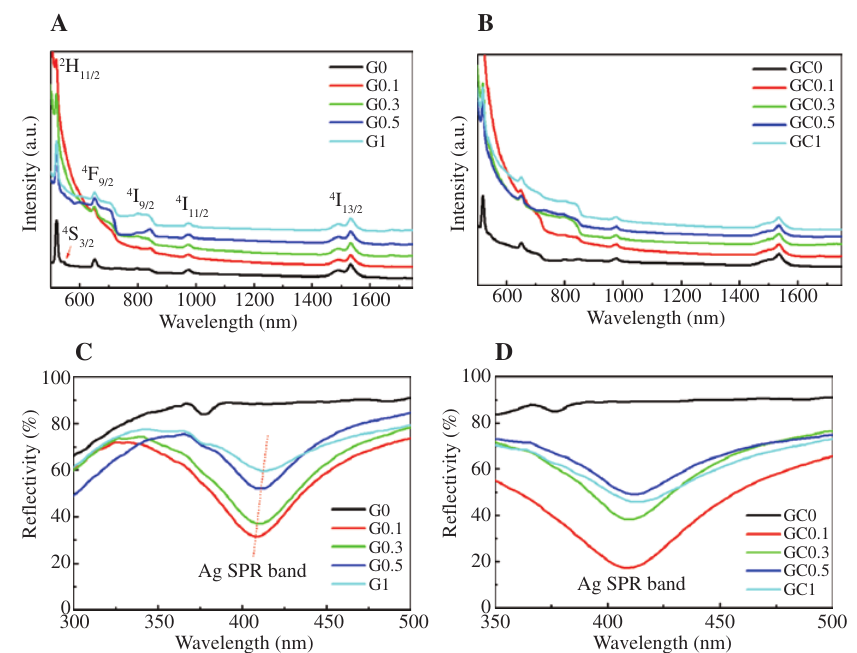
Figure 3: Absorption features of Er 3 + ions and Ag NPs in glasses and GCs. Absorption spectra ranging from 500 to 1750 nm of glasses (A) and GCs (B); diffuse reflectance spectra ranging from 300 to 500 nm in glasses (C) and GCs